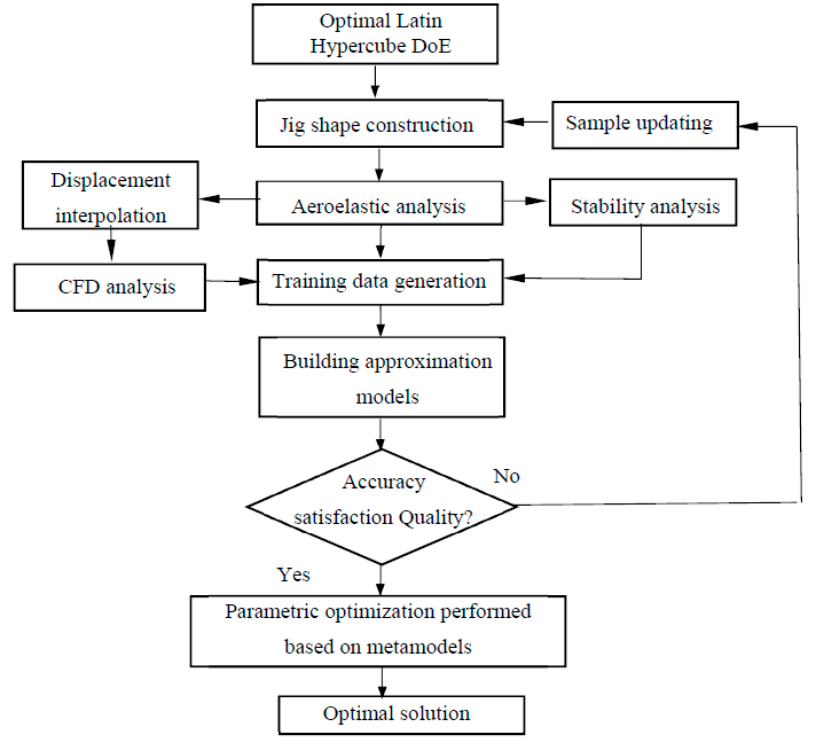
Figure 6. GP metamodel-assisted optimization flowchart.